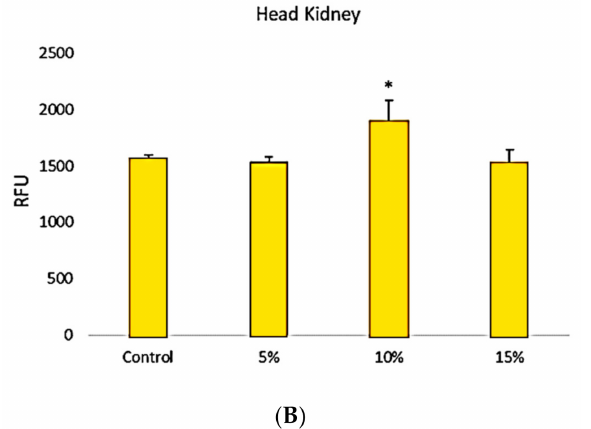
Figure 5. Effect of acetyl-xylogalactan on phagocytotic activities of Nile tilapia liver and head-kidney cells. ( A ) Phagocytotic activity of liver cells of Nile tilapia fed with acetyl-xylogalactan for 4 weeks. ( B ) Phagocytotic activity of head-kidney cells of Nile tilapia fed with acetyl-xylogalactan for 4 weeks. * p < 0.05. All treatment groups were compared to the control